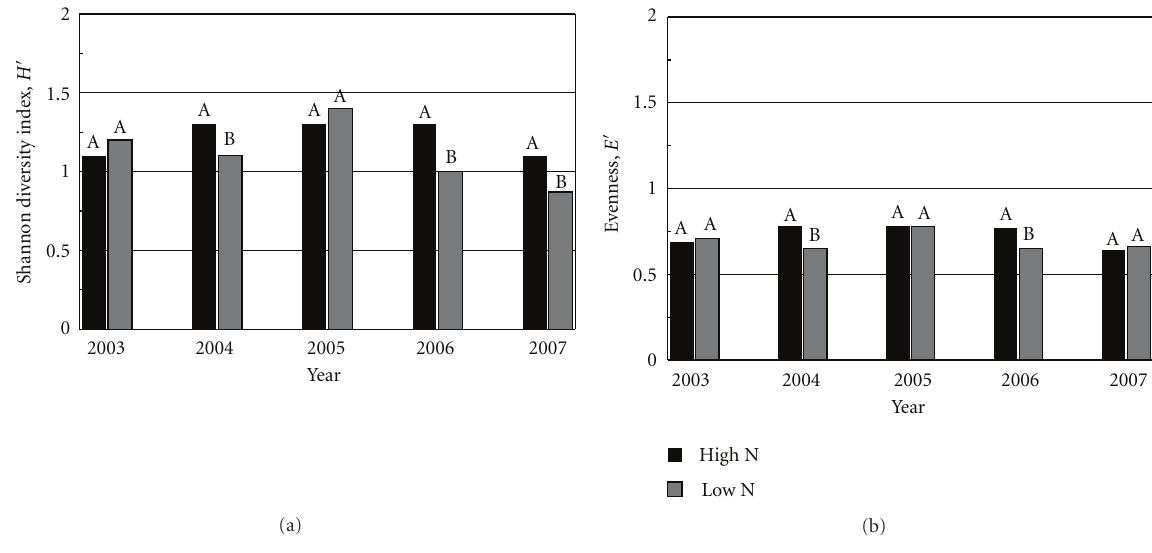
Figure 4: Mean responses for (a) Shannon diversity index and (b) species evenness in pooled high versus low nitrogen treatments by year. Responses associated with di ff erent letters are significantly di ff erent ( P < 0 . 05).